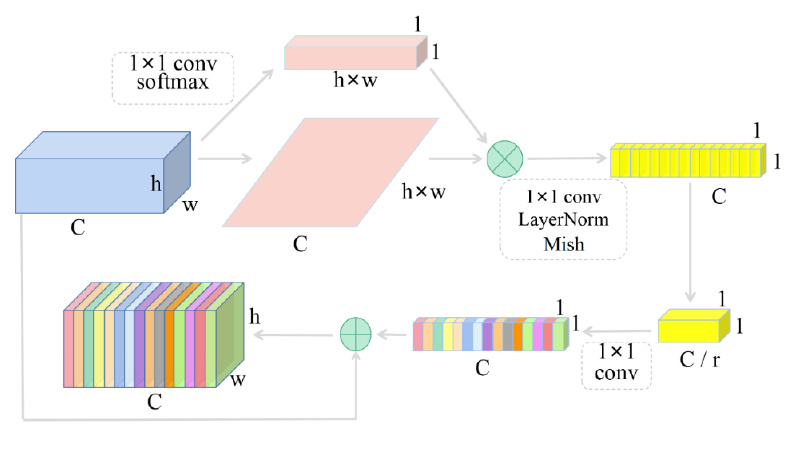
Figure 2. Global context attention